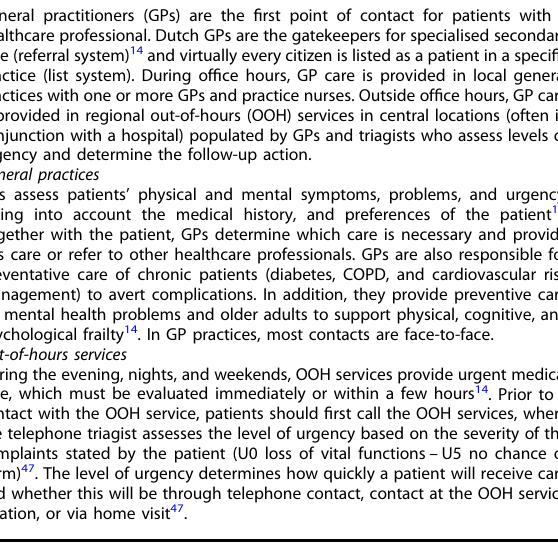
Table 1. Characteristics of the patient populations in the databases for GP practices and OOH